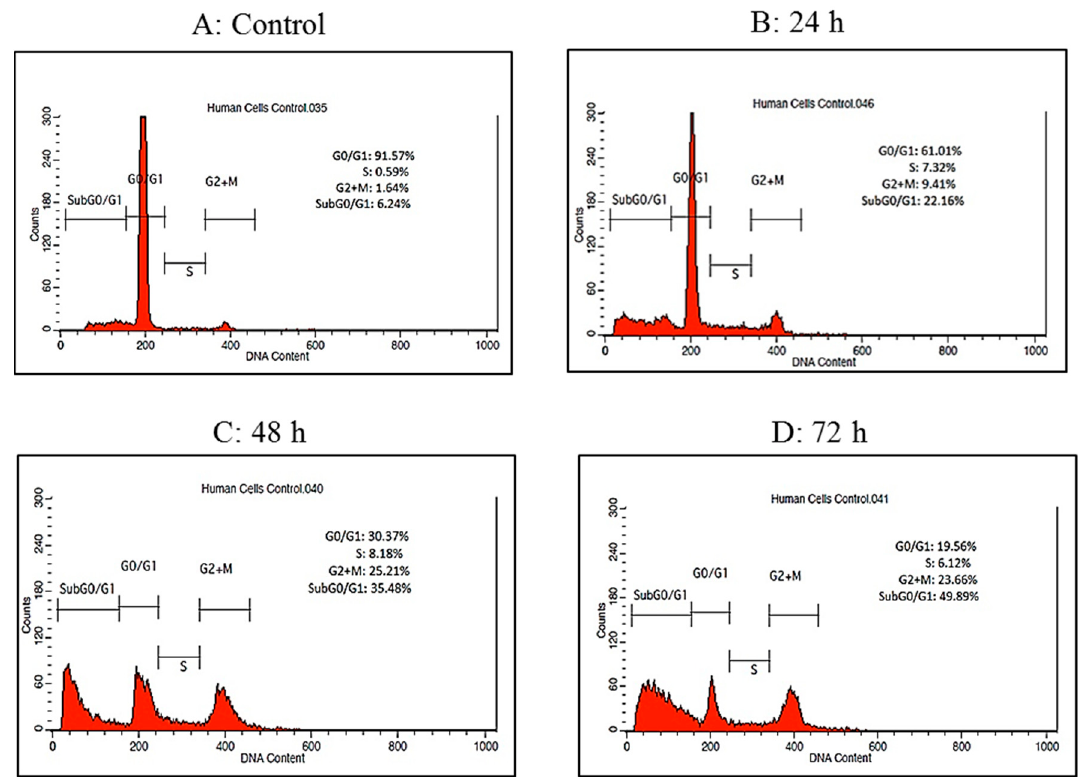
Figure 8. The time-dependent distribution of the MCF-7 cells exposed to raphasatin at the various stages of the cell cycle. MCF-7 cells were treated with IC 50 concentration of raphasatin (9.84 µM) for 24 h ( B ), 48 h ( C ) and 72 h ( D ) compared with untreated cells ( A ). Raphasatin arrested the MCF-7 cells at the G 2 + M phase as analyzed by flow cytometry. The data represent one of three independent experiments.